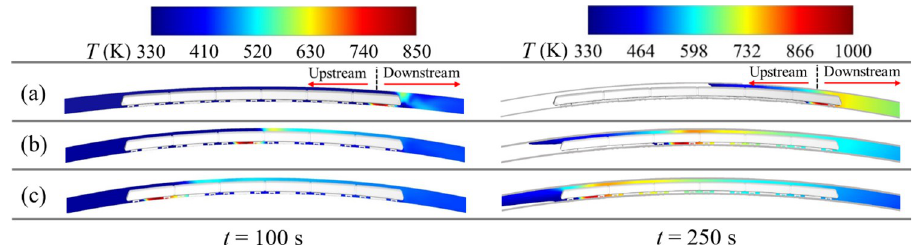
Fig 12. Temperature variation for different fire locations. (a) Head car; (b) middle car; (c) tail